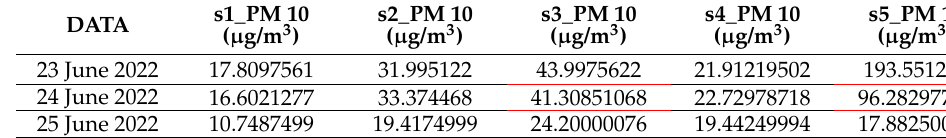
Table 4. Detected average of the PM 10.